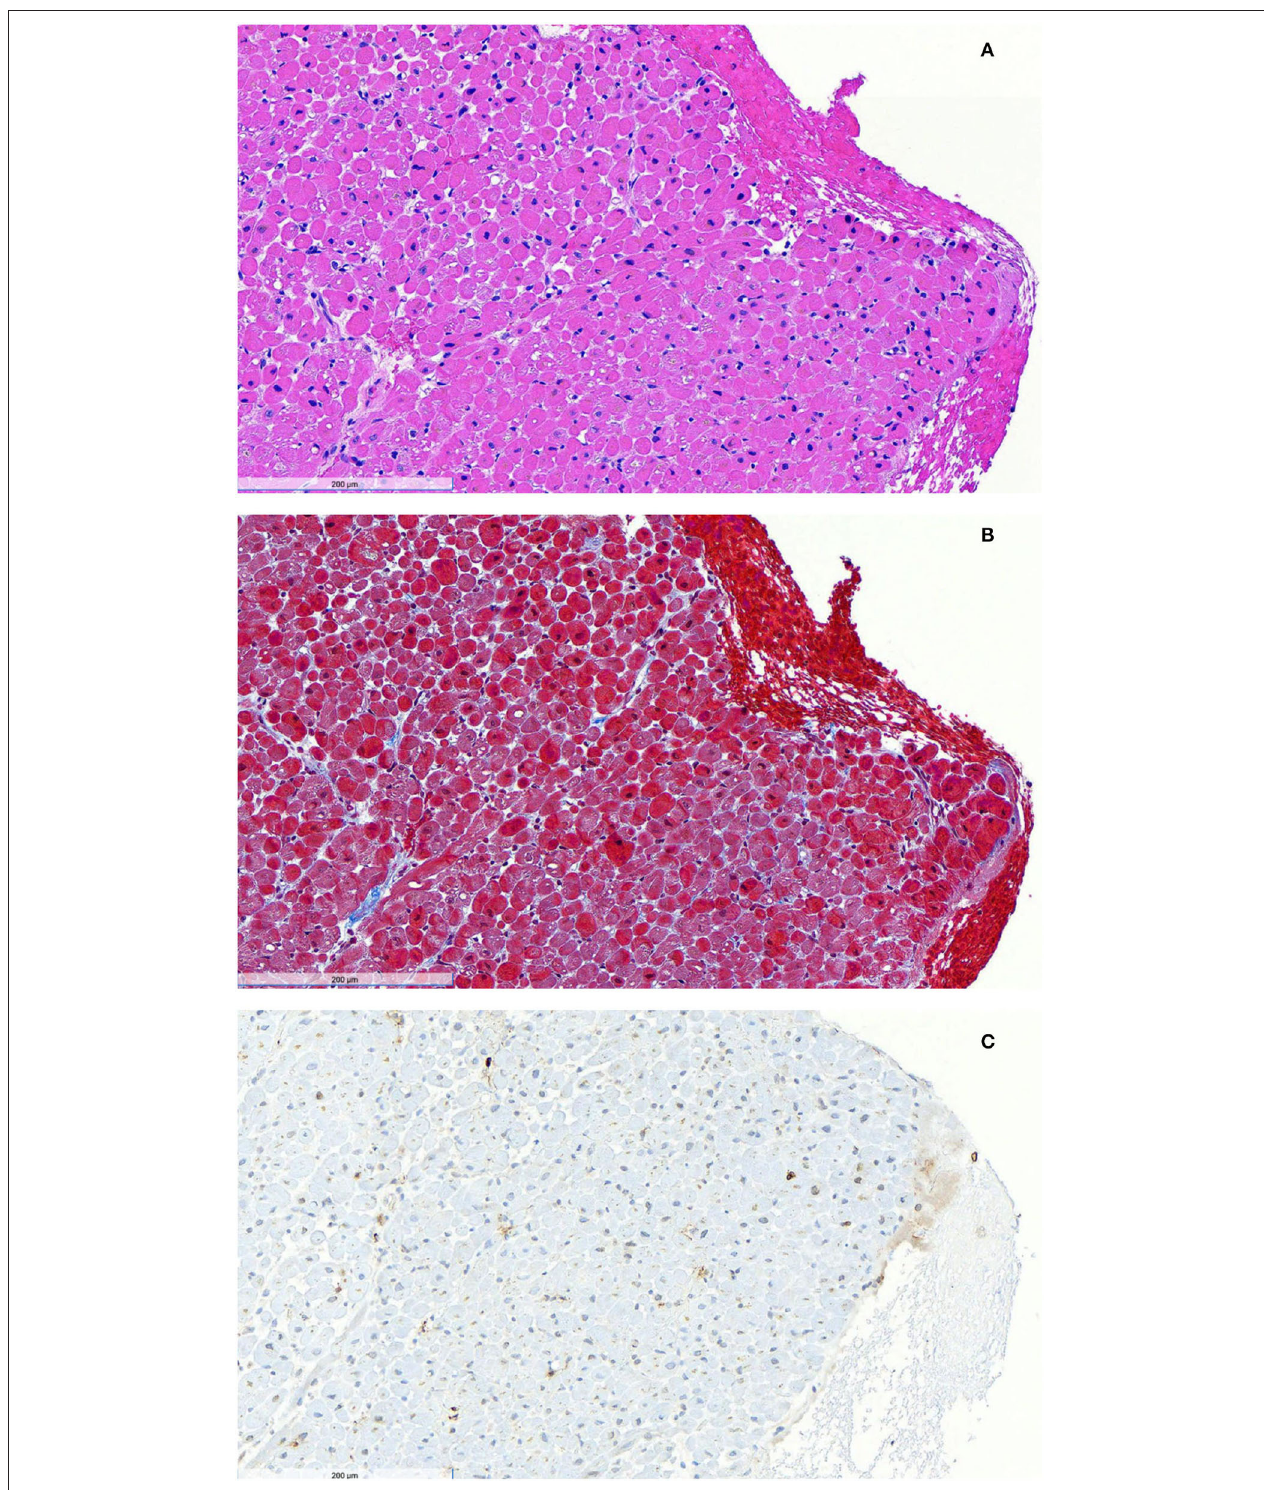
FIGURE 1 | Endomyocardial biopsy after initiation of steroid therapy. Hematoxylin and eosin staining (A) shows no acute myocyte necrosis and no significant interstitial expansion. No granulomas or giant cells were observed. Masson trichrome staining (B) shows focal mild blue-stained fibrosis. Immunoperoxidase staining for CD3 (C) reveals a slight infiltrate of brown CD3-positive T lymphocytes. Immunoperoxidase staining for CD68 demonstrated a diffuse mild infiltrate of CD68-positive macrophages. There was no evidence of amyloid on Congo red stain, no endocardial fibroelastosis on Movat stain, no iron deposition on Fe stain, and no excessive glycogen deposition on PAS stain. Toluidine blue-stained EM thick sections showed mild endocardial fibrosis and some endocardial lipid droplets.